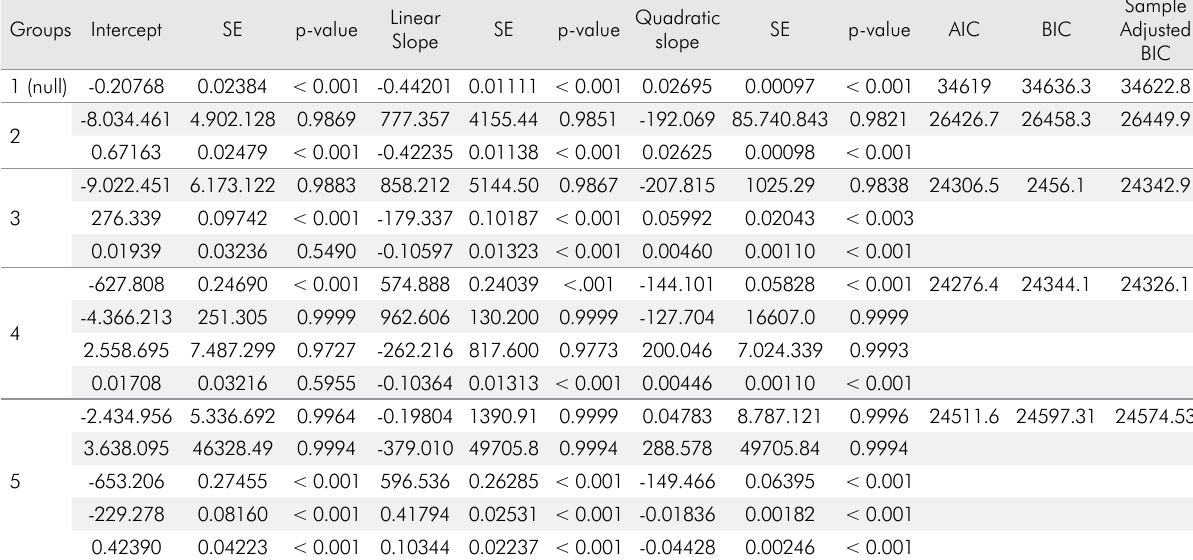
Table 2. The goodness of fit statistics and parameter estimates for quadratic trajectories of dentistry procedures restriction. Groups